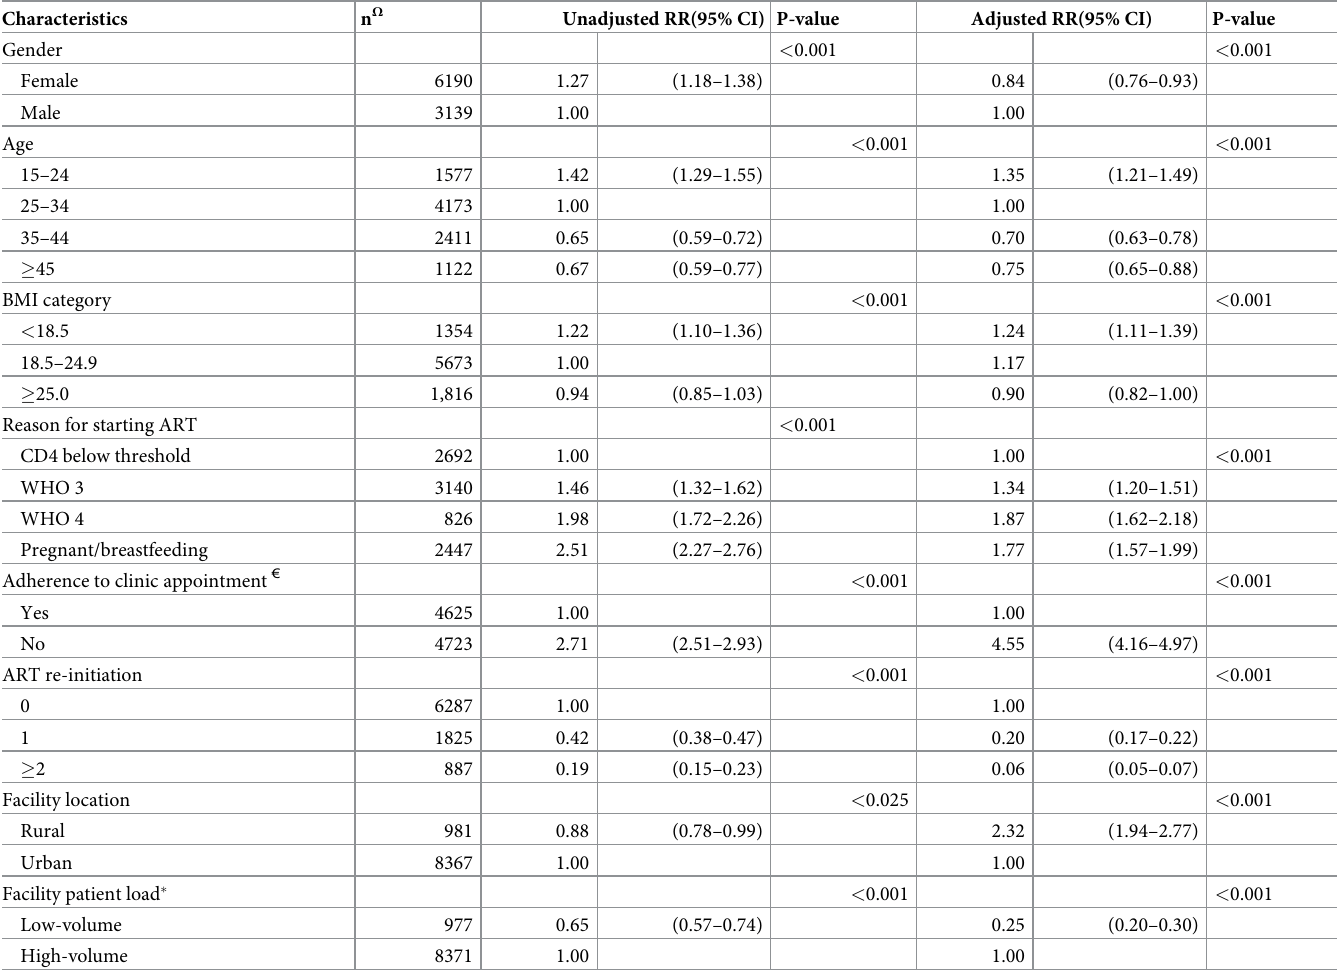
Table 4. Univariable and multivariable model of characteristics associated with loss to follow-up from ART care in Lilongwe, Malawi.